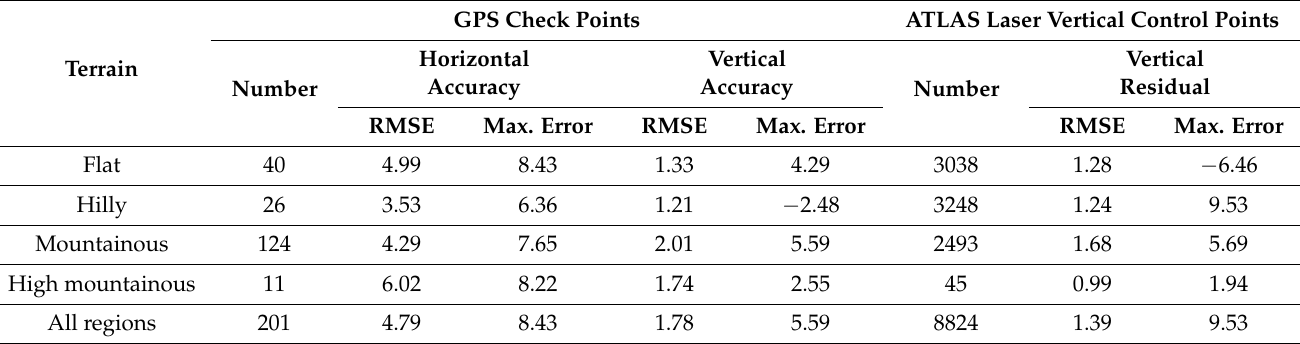
Table 9. Experimental results of integrated processing of GF7 experimental data (fourth group).